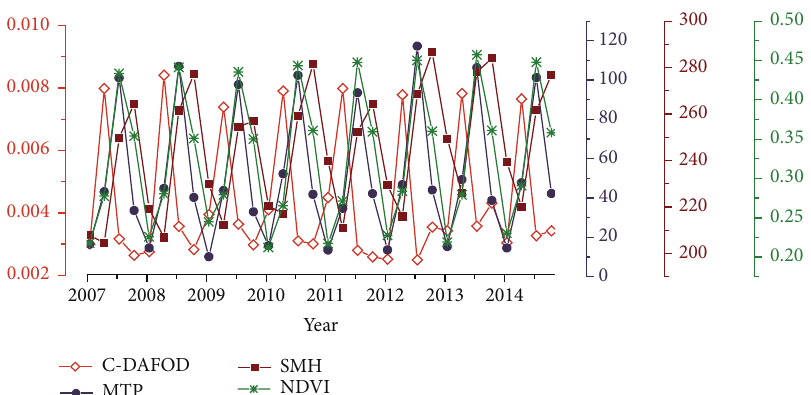
Figure 4: The interannual variability in the C-DAFOD, MTP, SMH, and NDVI as obtained from the multiyear seasonal mean observations over China (all the grid cells in the area of China are used in the calculation of average) from 2007 to 2014.